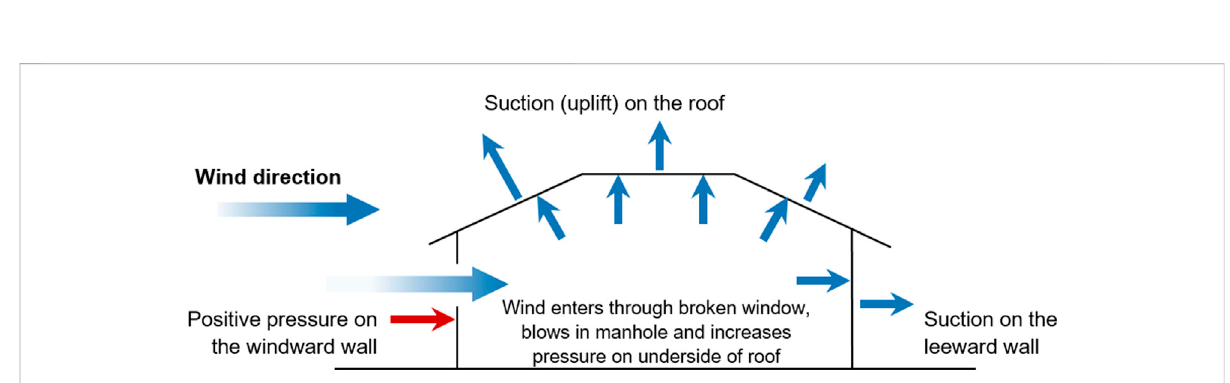
FIGURE 2 Typical internal pressures on a building with an opening on a windward